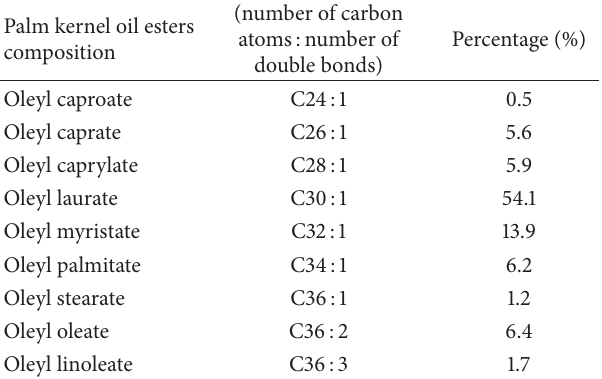
Table 1: The percentage of fatty acid composition in palm kernel oil